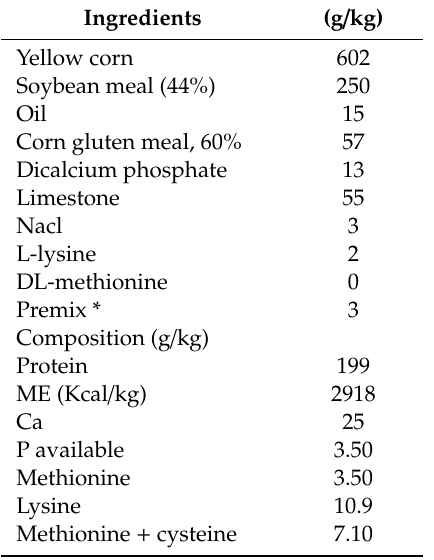
Table 1. Ingredients and nutrient contents of the basal diet of Japanese quail. Ingredients (g /